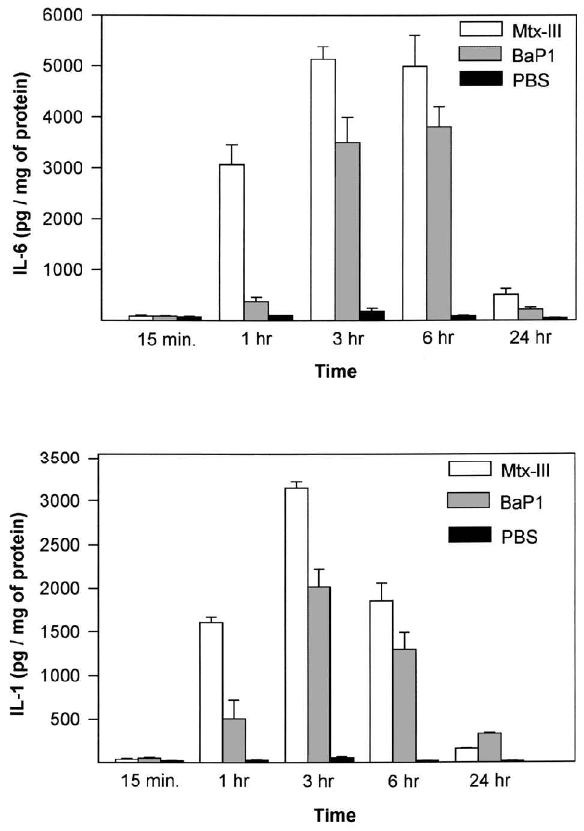
FIG. 2. Increments of IL-1 b and IL-6 in muscle homogenates after i.m. injection of 60 m g of MT-III or BaP1, dissolved in 60 m l of saline solution. Control mice received saline solution alone. Mice were injected in the right gastrocnemius and, at various time intervals, they were killed and the injected muscle was excised, weighed and homogenized in 2.0ml of saline solution. After centrifugation, cytokine levels were quantitated by enzyme-linked immunosorbent assay (see Materials and methods). Results are presented as mean ± standard deviation ( n =